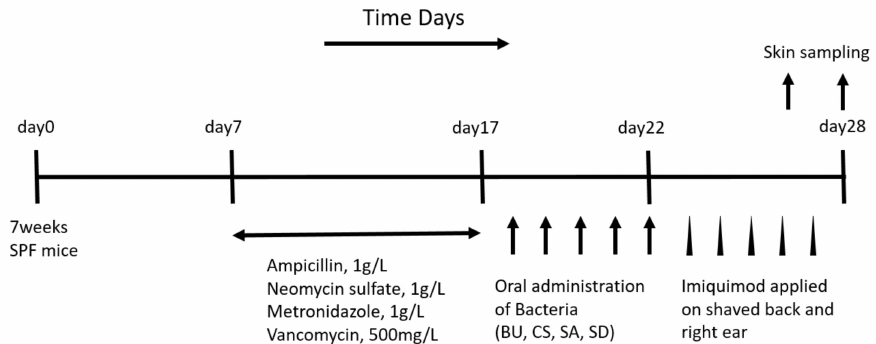
Figure 2. Experimental design.